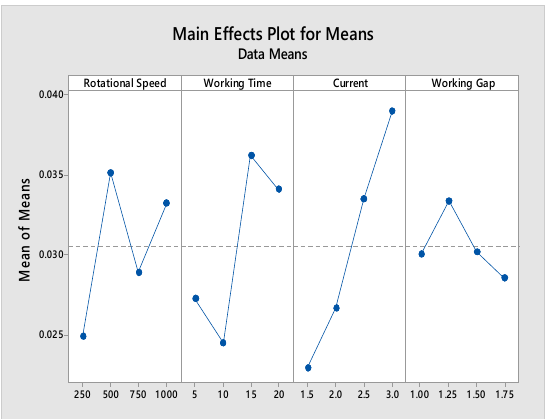
Main Effects Plot for Means Data